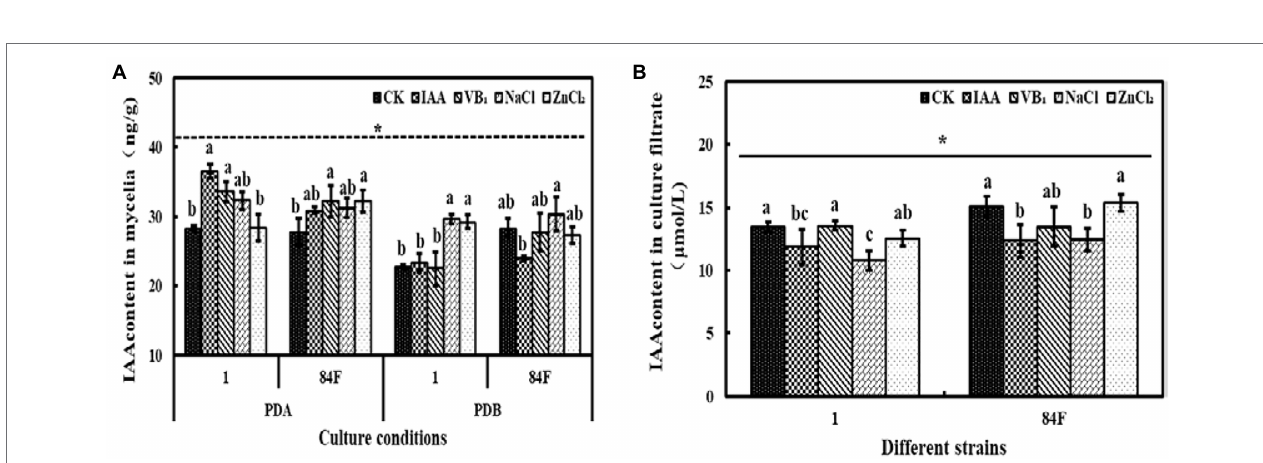
FIGURE 7 | Indole-3-acetic acid content of E. sinensis under different treatments for 4 weeks. (A) is IAA content in mycelia, and (B) is IAA content in culture filtrate. The same as Figure 1 .